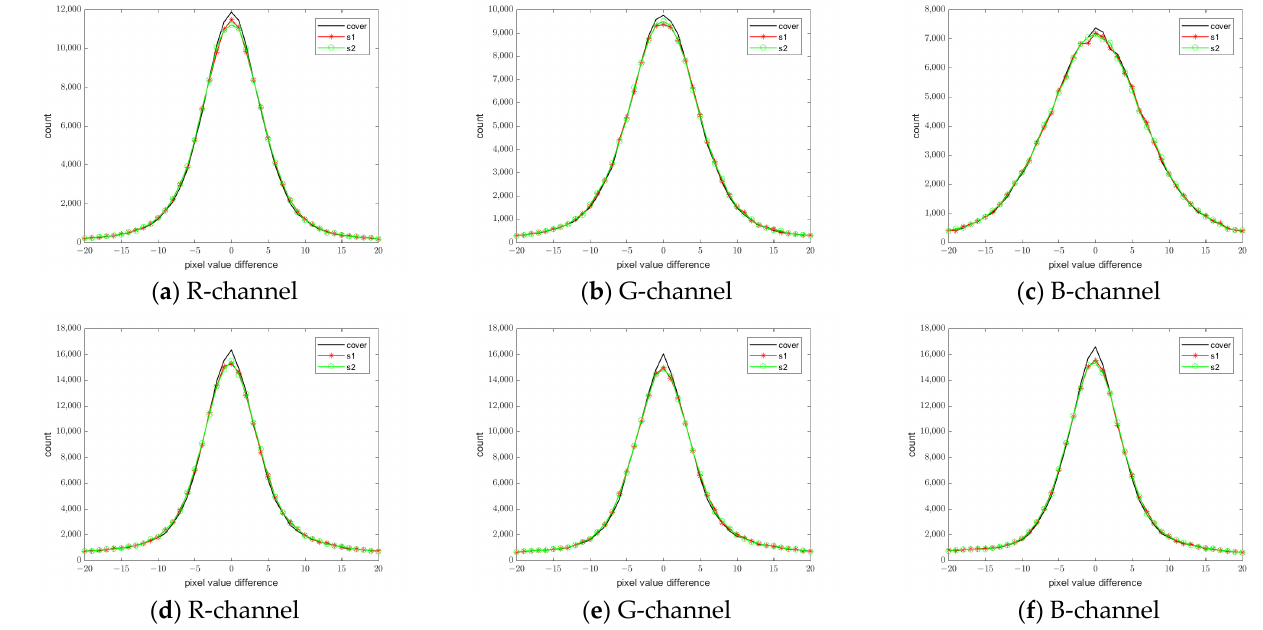
Figure 12. The PVD histograms for the test image “Lena” (top row) and those for “Kodim07”.